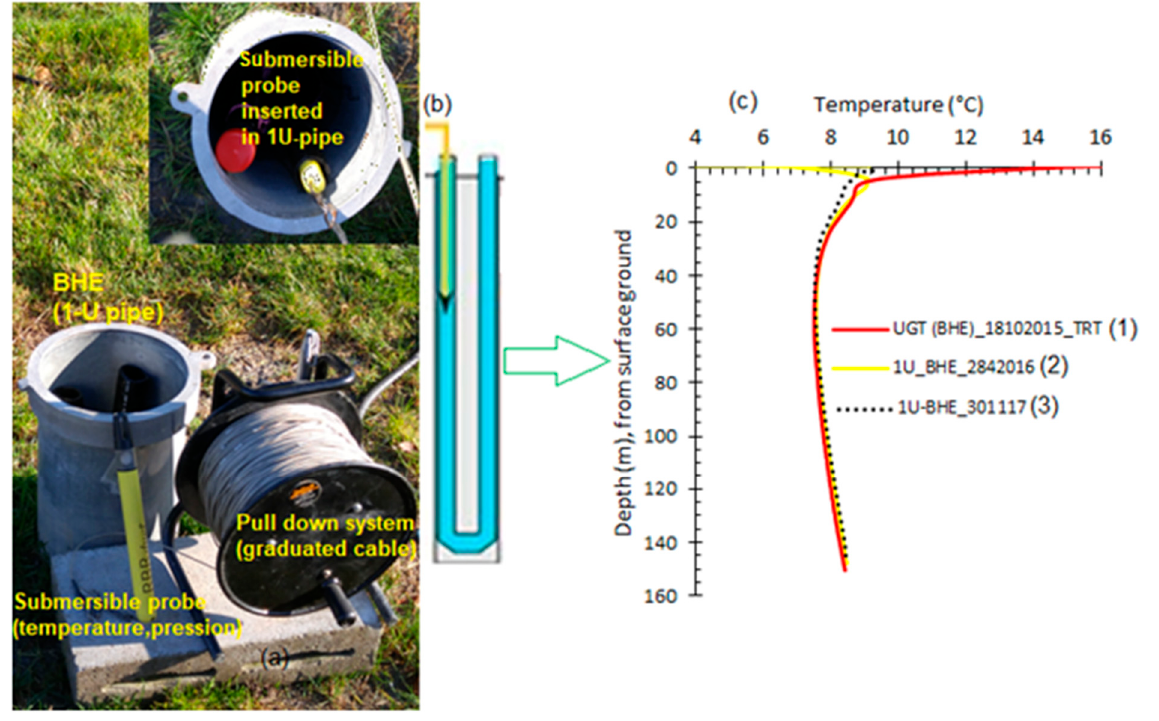
Figure 5. ( a ) Field equipment for ground temperature profile measurement at INRS geothermal experimental site (Quebec), with examples of ( b ) how to conduct measurements in the single U-pipe BHE and ( c ) results of observed ground temperature profiling; (2) and (3) are uncorrected for water level rise in the 1-U pipe, while (1) is corrected, respectively (see field protocol in Pambou et al. [16]).